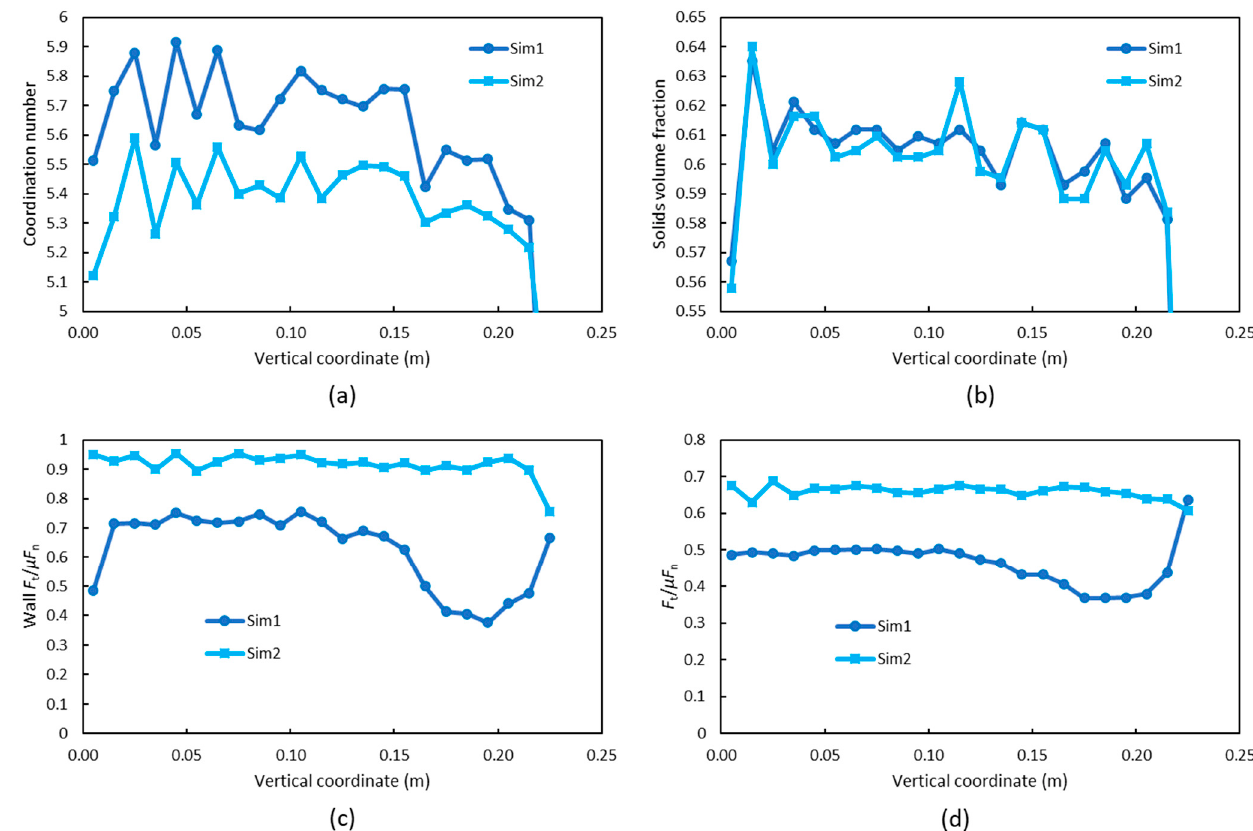
Figure 7. Variation along the vertical coordinate of the coordination number ( a ), solids volume fraction ( b ), particle-wall F t / µ F n ratio ( c ) and overall F t / µ F n ratio ( d ).